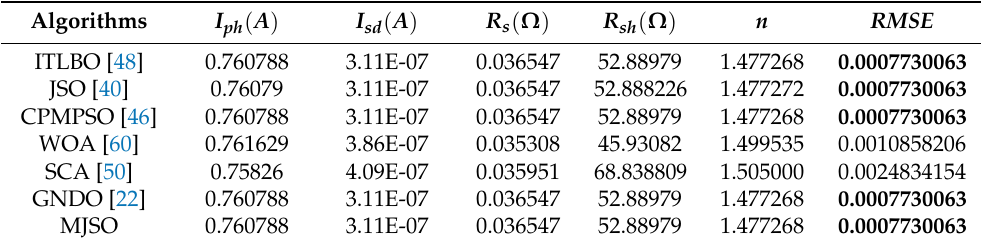
Table 6. Comparison of the R.T.C. France SDM based on the best-extracted parameter values and their RMSE.